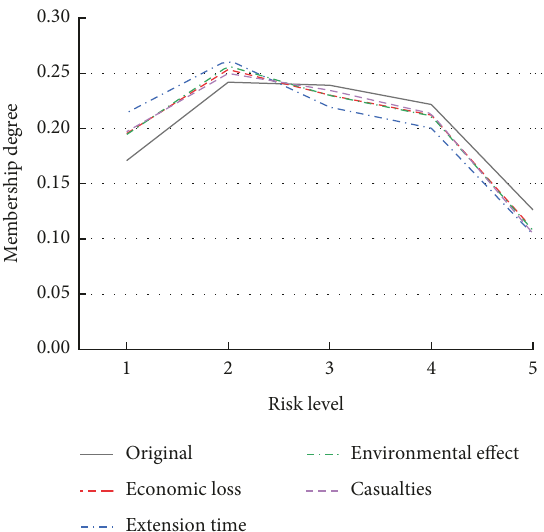
Figure 11: Effect of changes in the level of each loss indicator on the overall risk level without considering the weight of loss in- dicators in the case of uneven settlement of the foundation.